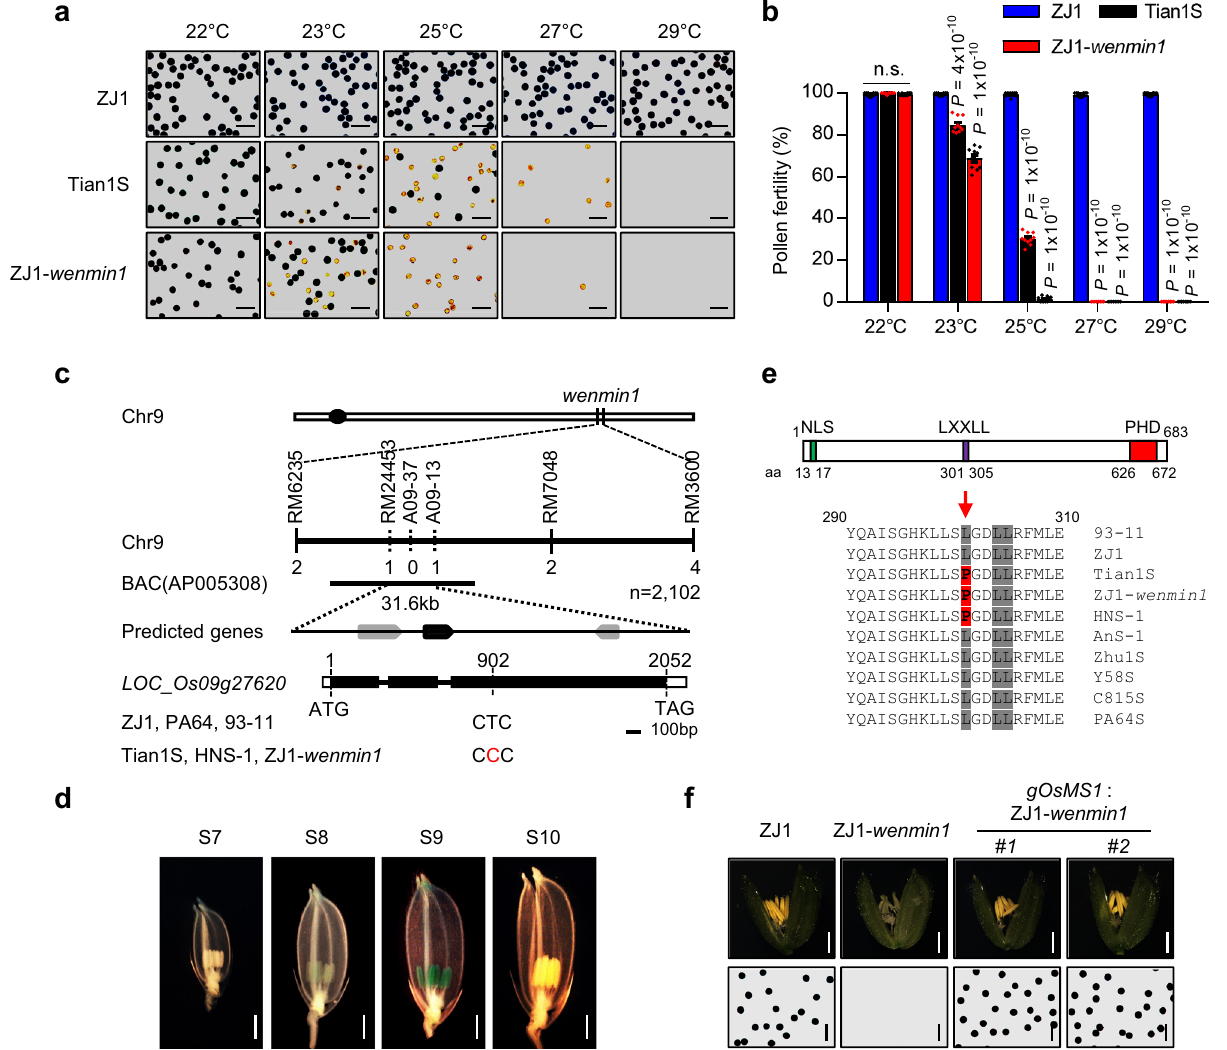
Fig. 1 Phenotypes and identi fi cation of the wenmin1 allele. a Pollen fertility of ZJ1, Tian1S and ZJ1- wenmin1 at the indicated day average temperature (DAT). b Statistical analysis of ( a ). Data are presented as means± s.e.m. ( n = 10 biological replicates). P values indicate the signi fi cant differences relative to ZJ1 at the indicated temperatures. Two-tailed unpaired t -test was used for statistical analysis. n.s., not signi fi cant. c Mapping and identi fi cation of wenmin1 . Arrows, predicted genes; black boxes, exons; black lines, introns. Numbers indicate the exon length. The speci fi c single nucleotide polymorphism in Tian1S, HNS-1, and ZJ1- wenmin1 was shown in red. d OsMS1-GUS is speci fi cally detectable in the stages 8 and 9 anthers. S7, Stage 7; S8, stage 8; S9, stage 9; S10, stage 10. e Schematic diagram of OsMS1 protein structure. Green, purple and red rectangles indicate NLS, LXXLL motif, and PHD domain, respectively. aa, amino acids. The mutated amino acids (L301P) in Tian1S, HNS-1, and ZJ1- wenmin1 are shaded in red. f Spikelet (up) and pollen (down) phenotypes of ZJ1, ZJ1- wenmin1 , and gOsMS1: ZJ1- wenmin1 lines (#1 and #2). Scale bars, 100 μ m ( a ), 1 mm ( d ), 1 mm ( f , up), 100 μ m ( f , down). Representative results of at least three independent experiments in ( d ) and ( f ) are shown. Source data are provided as a Source data fi